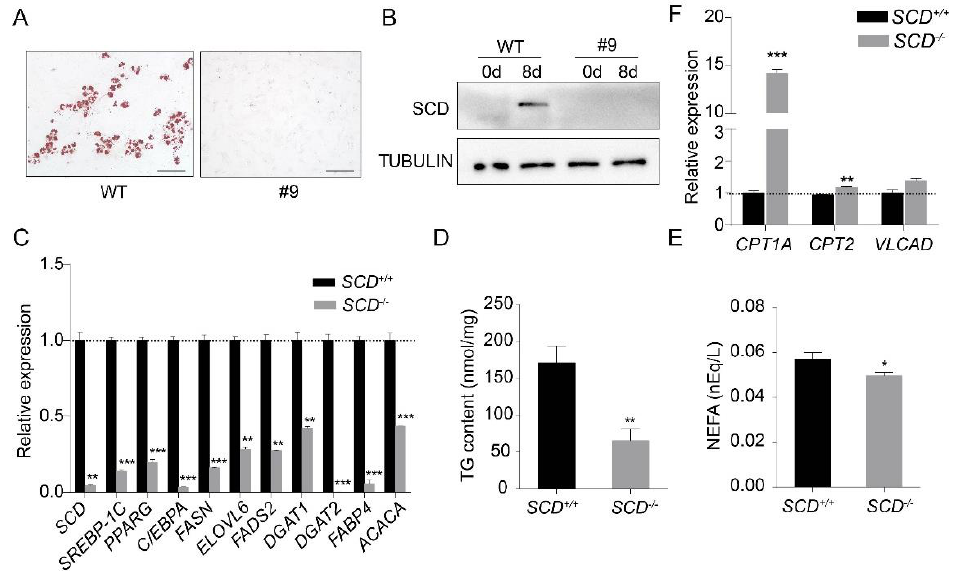
Figure 4. SCD knockout inhibited PEF transdifferentiation into mature adipocytes. ( A ) SCD +/+ and SCD -/- were differentiated into adipocytes in vitro. Cells were subjected to oil red O staining after differentiation. Scale bar, 100 μm. ( B ) Western blot analysis of SCD in nondifferentiated and differentiated SCD +/+ and SCD -/- cells. TUBULIN was used as the loading control. Notably, SCD was undetectable in differentiated SCD -/- cells. ( C ) The expression levels of the genes related to lipid synthesis, in both the SCD +/+ and SCD -/- cells. Notably, all of these genes were significantly lower in the SCD -/- cells (n = 3/group). ( D and E ) TG ( n = 7/group) and NEFA (n = 6/group) content levels in the SCD +/+ and SCD -/- cells. (F) The expression levels of the genes related to fatty acid β -oxidation in both the SCD +/+ and SCD -/- cells (n = 3/group); * p < 0.05, ** p < 0.01 and *** p < 0.001.